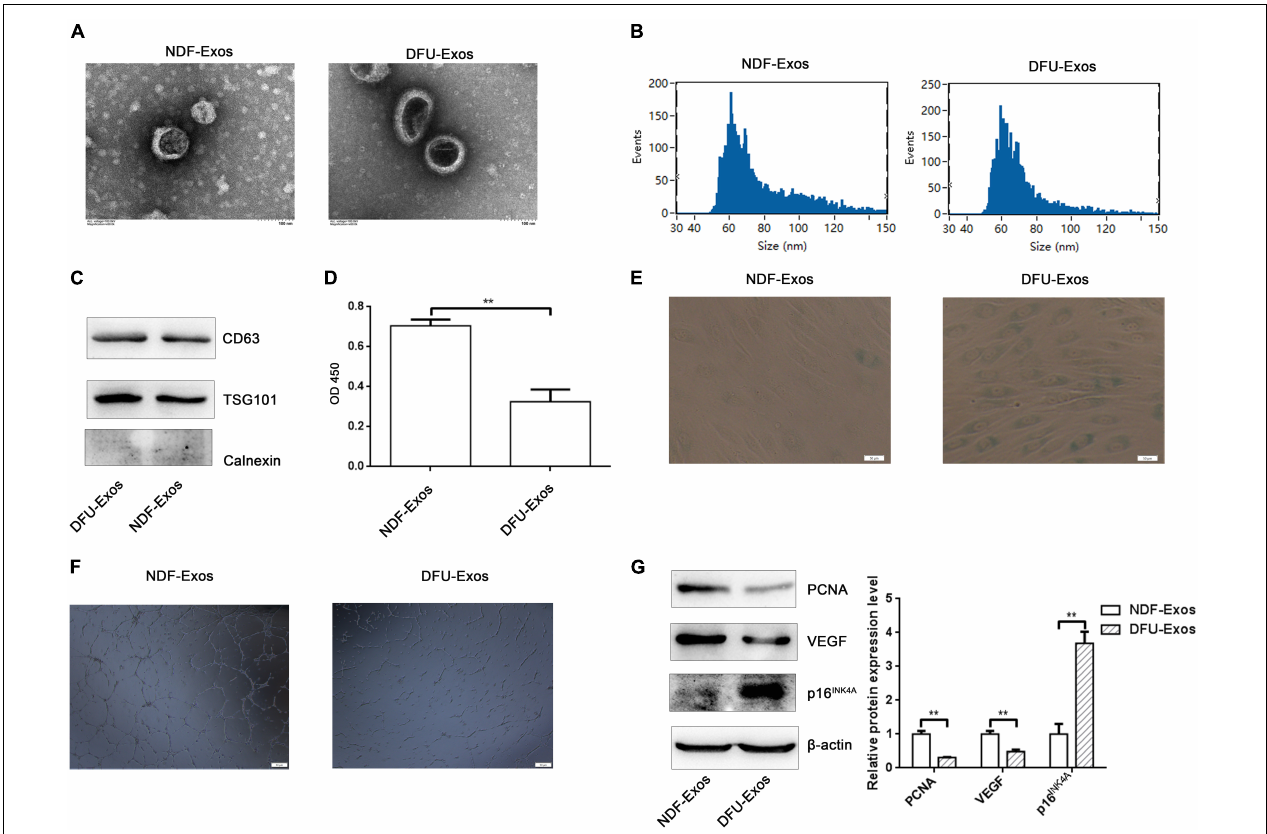
FIGURE 1 | Exosomes secreted into the plasma of patients with DFU promoted cell senescence and inhibited tube formation in HUVECs. (A) TEM image showing the shape and sides of exosomes isolated from NDF-Exos and DFU-Exos. (B) NTA results showing the size of the exosomes. (C) Western blotting showing the expression of CD63, TSG101, and Calnexin in the exosomes. (D) Results of CCK-8 assay to detect the effects of NDF-Exos and DFU-Exos on cell viability. ** P < 0.01 NDF-Exos vs. DFU-Exos. (E) β -gal stain showing β -galactosidase activity in HUVECs treated with NDF-Exos and DFU-Exos. (F) Tube formation in NDF-Exos and DFU-Exos groups. (G) Western blotting showing the expression of PCNA, VEGF, and p16 INK4A in HUVECs incubated with exosomes. ** P < 0.01 DFU-Exos vs. NDF-Exos.